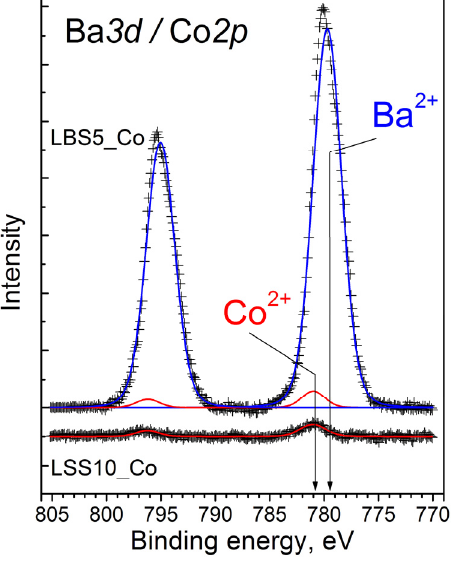
Figure 8. Ba 3d (blue line) and Co 2p (red line) core-levels spectra of La 0.95 Ba 0.05 ScO 3- δ + 0.5 wt% Co 3 O 4 and La 0.9 Sr 0.1 ScO 3- δ + 0.5 wt% Co 3 O 4 samples.